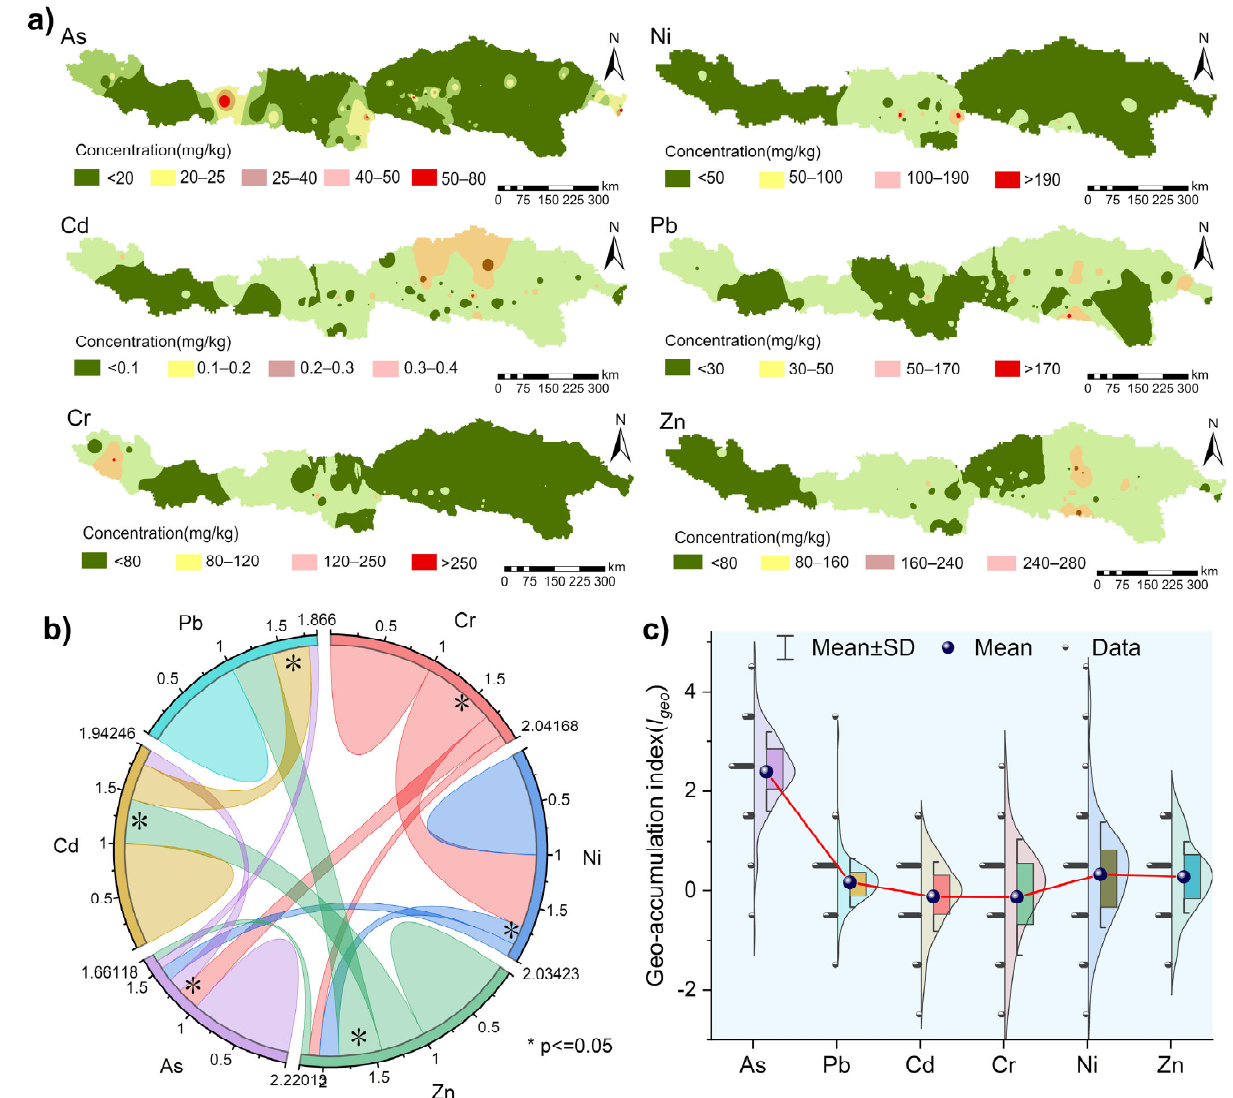
Figure 4. Spatial distribution and pollution assessment of six soil heavy metals (HMs). ( a ): The spatial distribution for soil HMs in the YTRB. ( b ): Pearson correlation analysis between soil HMs. The width represents the coefficient between the related HMs. ( c ): Evaluation of pollution levels of different HMs based on Geo ‐ accumulation assessment. Table 2. Descriptive statistics analysis results for soil heavy metals.